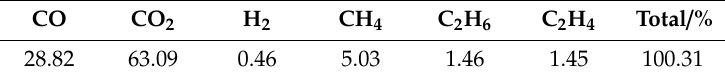
Table 3. The composition of the pyrolysis gas